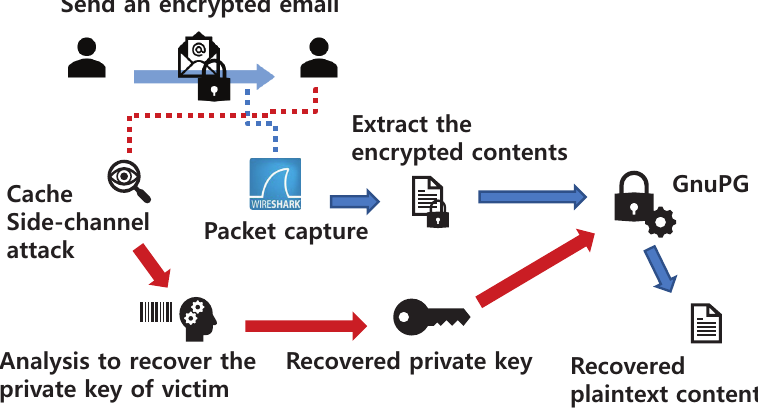
Figure 2. Overview of our attack scenario.